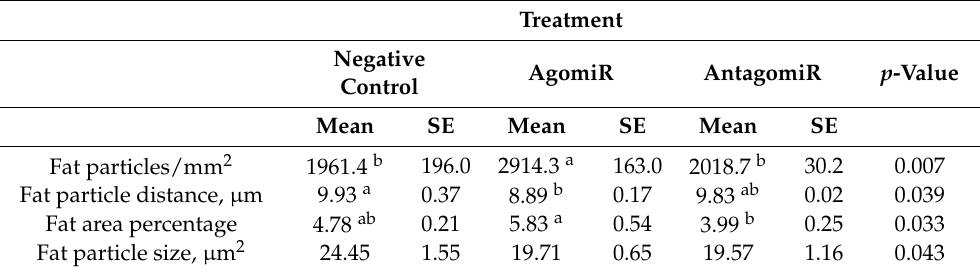
Fat particle distance, µ